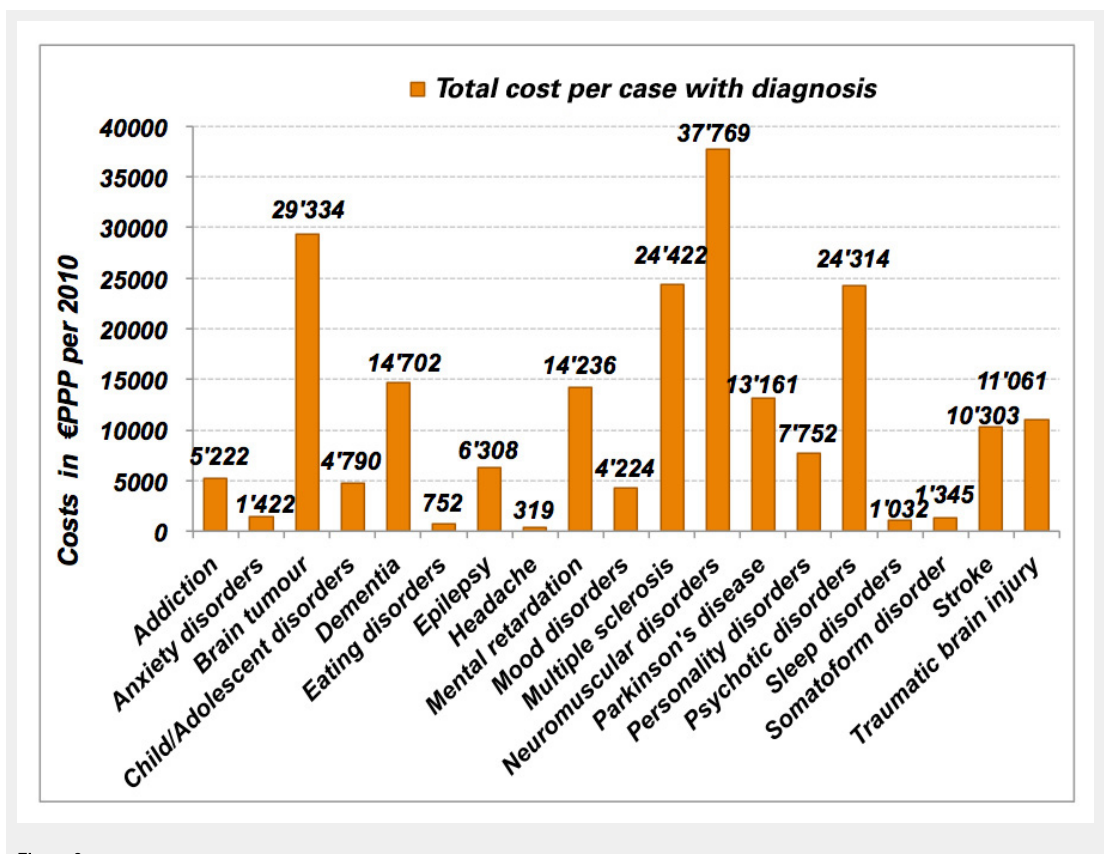
Figure 3 Total costs per affected subject in Switzerland.